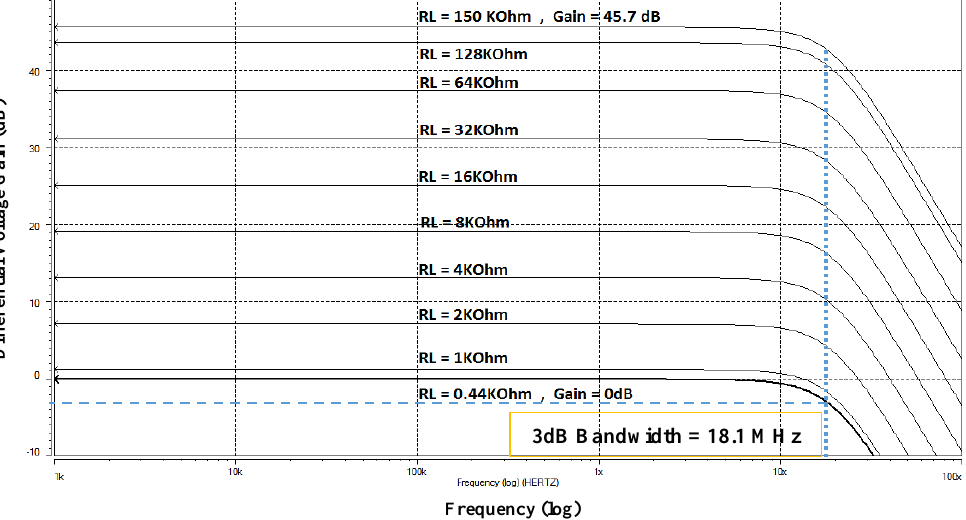
Figure 4. Frequency response of the voltage differential gains for different values of RL